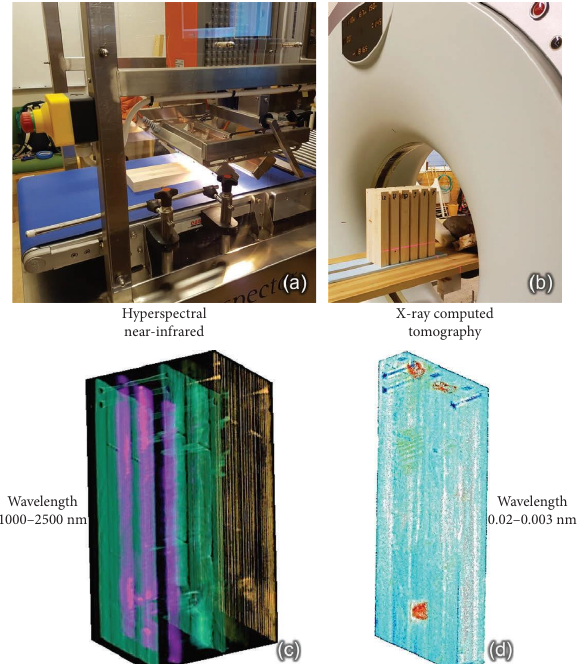
Figure 1: (a) Scanning cross-laminated timber (CLT) specimens with hyperspectral near-infrared (NIR) surface measurements, (b) X-ray computed tomography (CT) surface and internal bulk measurements, (c) projection of surface NIR data with layers in the cube representing diferent spectral bands, and (d) density of specimen volume from